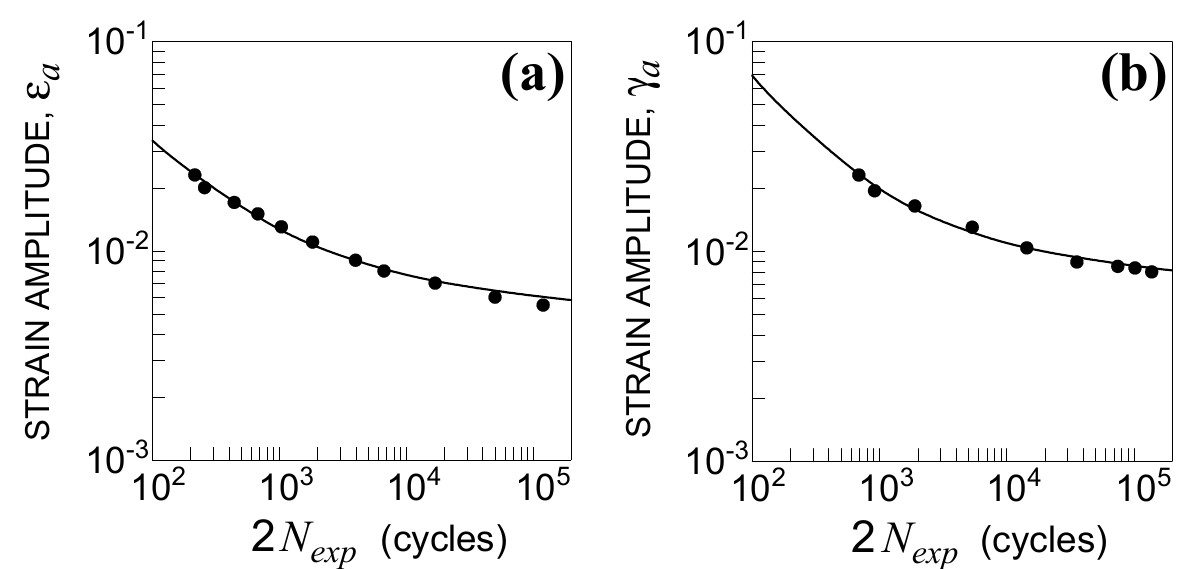
Figure 2. Uniaxial experimental results and Manson–Coffin curves under ( a ) tension and ( b ) torsion. Table 2. Experimental results under multiaxial loading [6]. The values of ϕ i , Φ i , ∆ ε path are